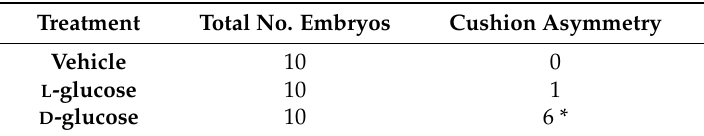
Figure 1. Hyperglycemia can lead to asymmetric endocardial outflow tract (OFT) cushions visible in the displaced lumen of cross-sectional images. Cross-sectional optical coherence tomography (OCT) images of the OFT showing a vehicle control ( A ), a vehicle control cross section labelled for reference ( B ), an osmotic control ( C ), a D -glucose-treated embryo with the lumen displaced towards the ventral portion of the OFT ( D ). Scale bar = 70 µm. Table 1. Incidence of OCT Cushion Asymmetry.